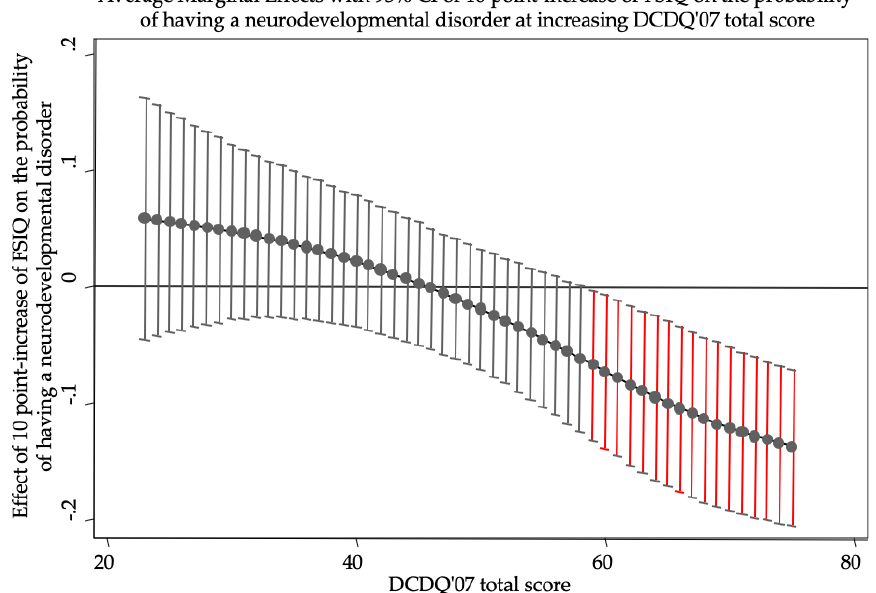
Table 2. Predictors of case-control status